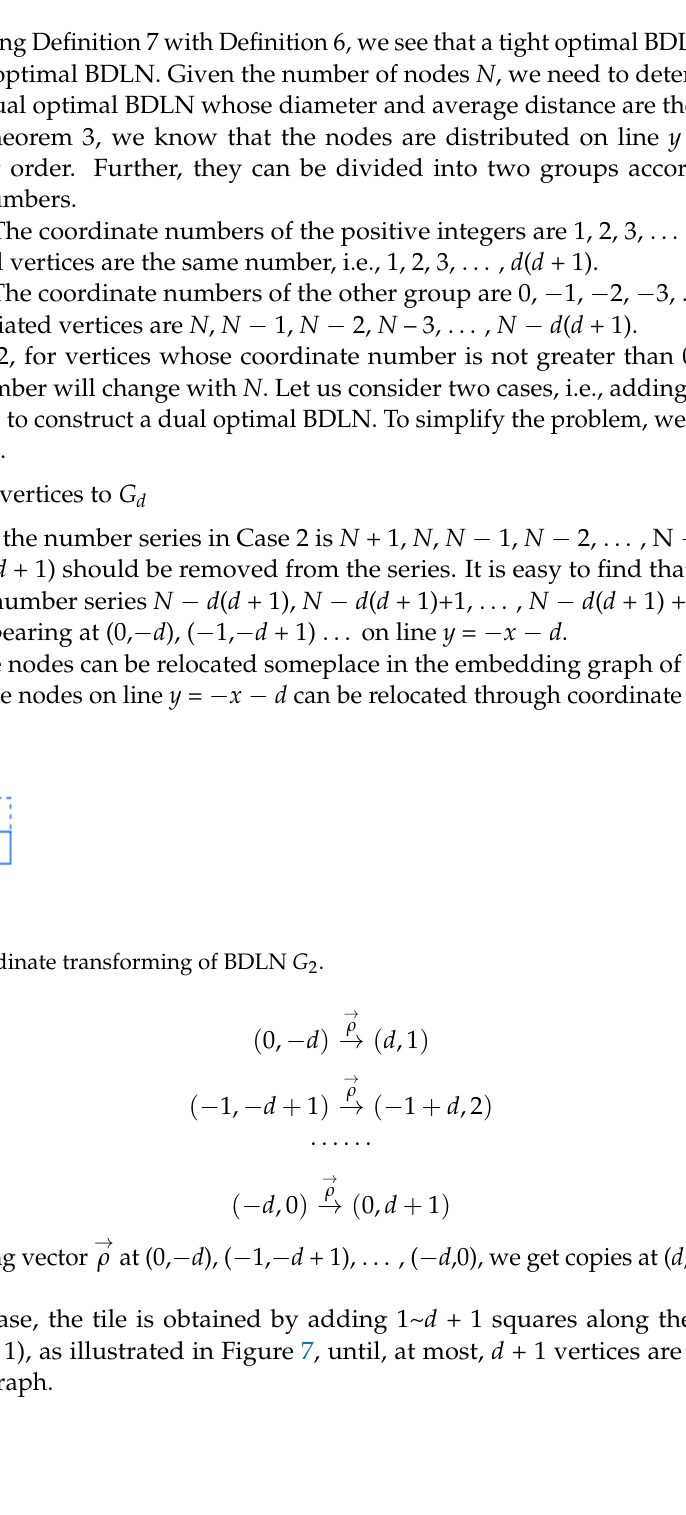
Figure 7. Adding vertices to G d . Lemma 10. When adding x ( 1 ≤ 𝑥 ≤ 𝑑 + 1 ) vertices to 𝐺 (cid:3031) , if all the x vertices have a distance from the origin of d + 1, then 𝐺(𝑁 + 𝑥; ±𝑑, ±(𝑑 + 1)) is a dual optimal BDLN. Proof. Suppose the diameter of 𝐺(𝑁 + 𝑥; ±𝑑, ±(𝑑 + 1)) is not the minimum. In this case, there should be a vertex u whose distance from the origin is less than d + 1. Since the vertices are all located on G d , vertex u meeting such conditions is an impossibility. There- fore, the diameter of 𝐺(𝑁 + 𝑥; ±𝑑, ±(𝑑 + 1)) is the minimum, as is the average distance. As such, 𝐺(𝑁 + 𝑥; ±𝑑, ±(𝑑 + 1)) is a dual optimal BDLN with a minimum diameter and average distance. □ (2)